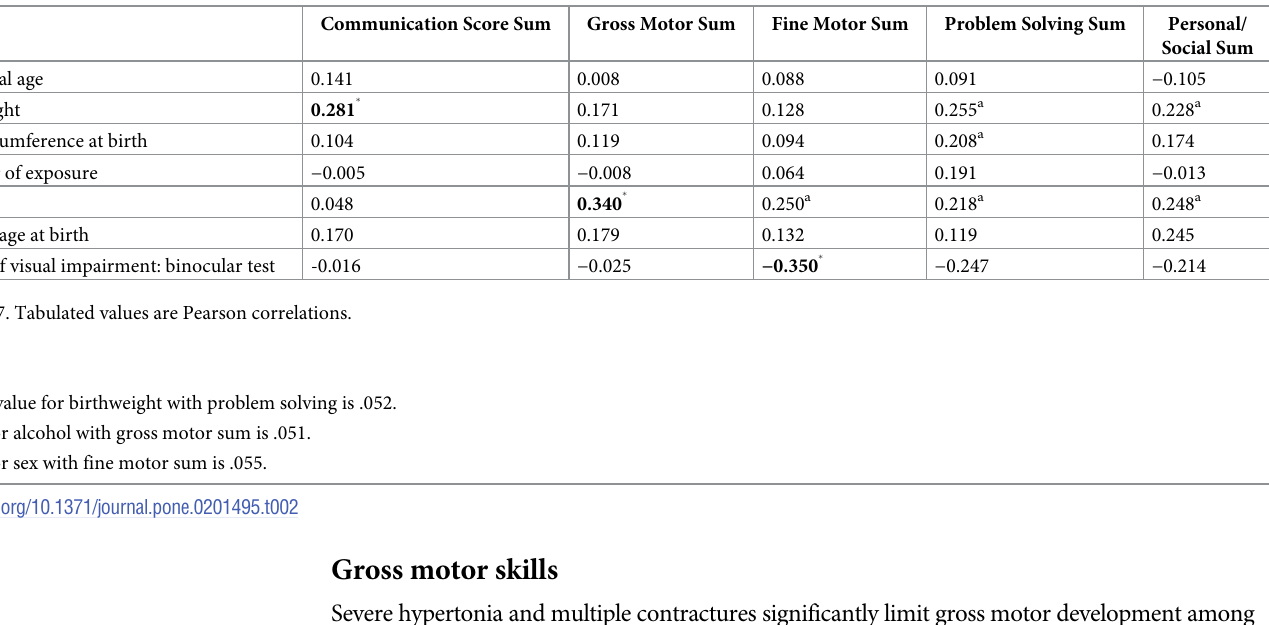
Table 2. Correlations between individual/family variables and developmental